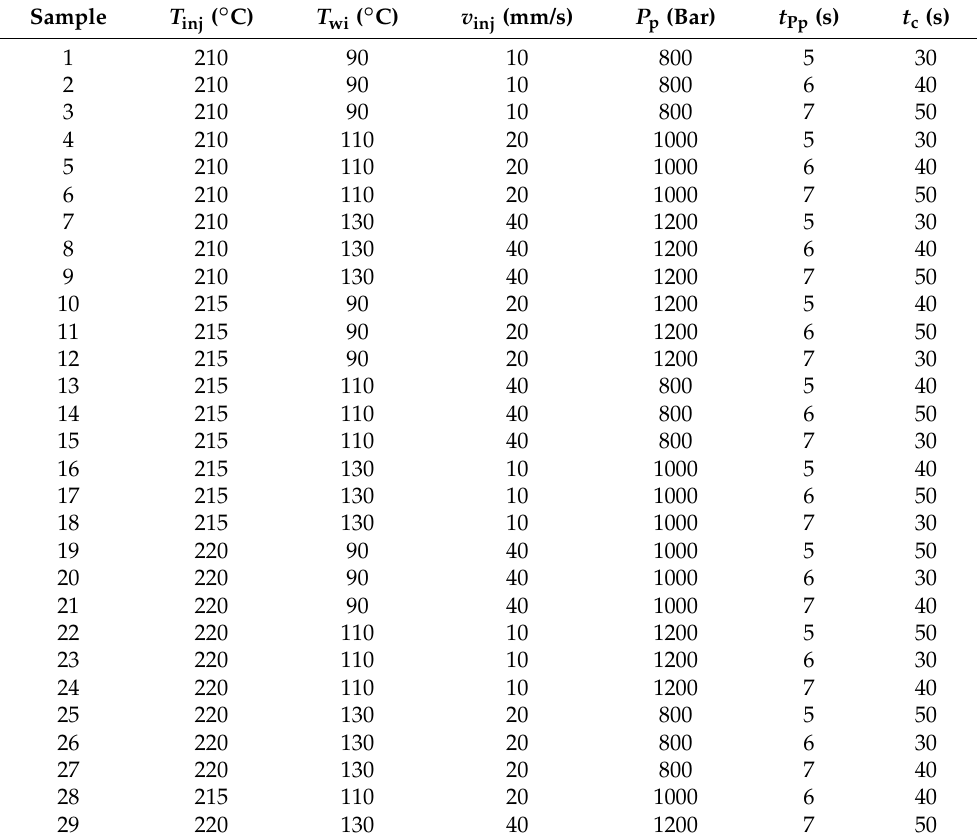
Measured manufactured gears and the corresponding injection moulding process parameters—injection temperature, water (mould) temperature, injection speed, packing pressure, packing pressure time, and cooling